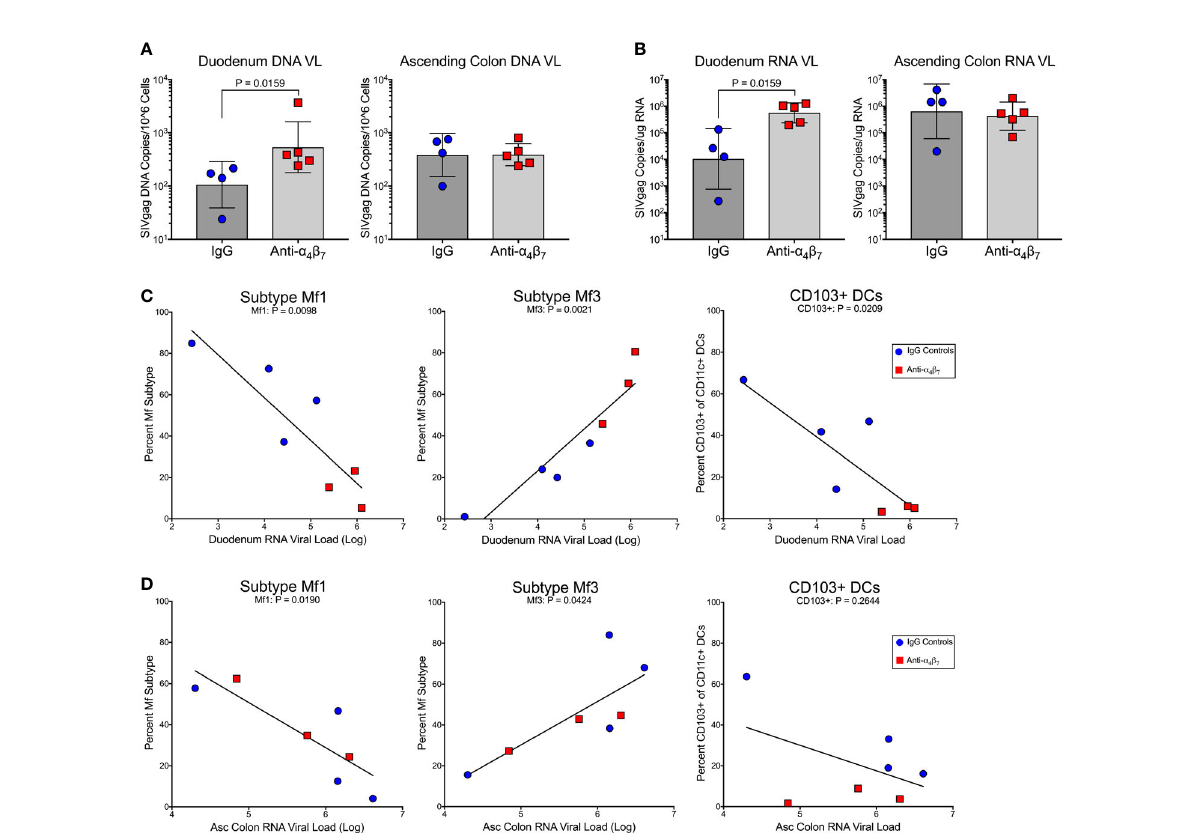
FIGURE 3 Anti- a 4 b 7 therapy was associated with higher small intestine tissue viral loads. (A) Tissue RNA viral loads were signi fi cantly higher in the duodenum of anti- a 4 b 7 -treated macaques compared to controls. (B) Tissue DNA viral loads normalized to cell number followed the same trend. (C) In the duodenum, viral loads were negatively associated with Mf1s and CD103+ DCs. Viral loads were positively associated with mature Mf3s. (D) In the ascending colon, a similar association was found with local viral load and macrophage maturity but not with CD103+ CD11c+